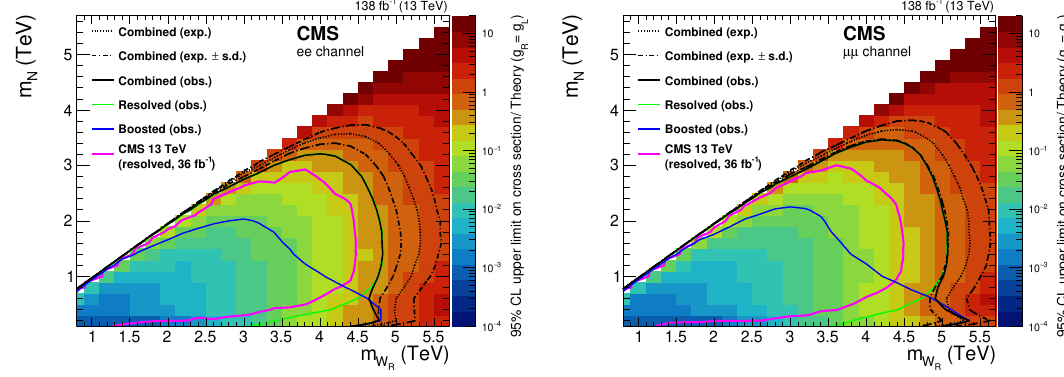
Figure 7 . The observed 95% CL upper limits on the product of the production cross sections and the branching fractions of a right-handed W boson divided by the theory expectation for a R coupling constant g equal to the SM coupling of the W boson ( g ), for the electron channel (left) R R L and muon channel (right). The observed exclusion regions are shown for the resolved (solid green), boosted (solid blue), and combined (solid black) channels, together with the expected exclusion region for the combined result (dotted black). The dash-dotted lines represent the 68% coverage of the boundaries of the expected exclusion regions. The observed exclusion regions obtained in the previous search performed by the CMS Collaboration [12] are bounded by the magenta lines. The biggest improvement can be seen in the m < 0 . 5 TeV region, where the new boosted category N greatly improves the sensitivity over the previous